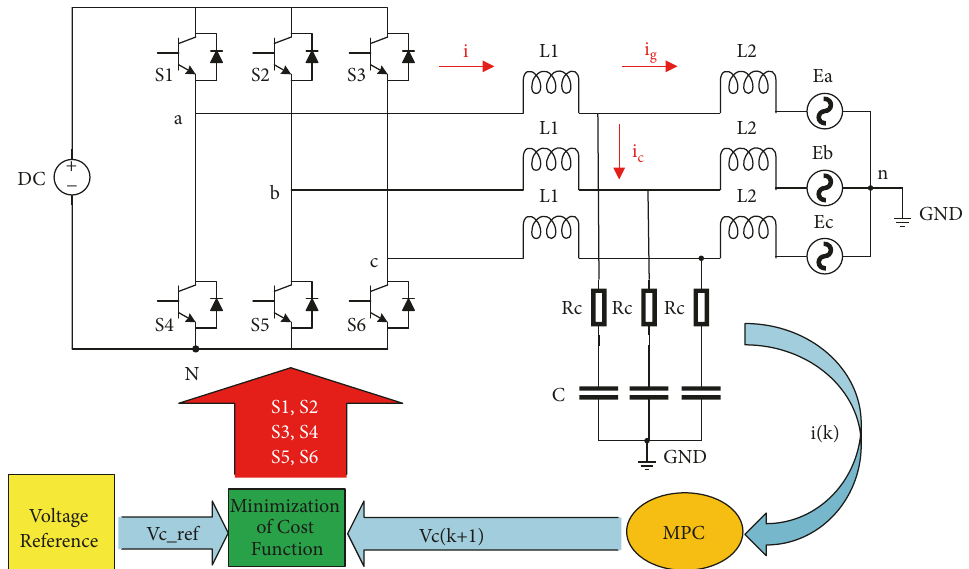
Figure 3: Control diagram of a three-phase inverter connected to the